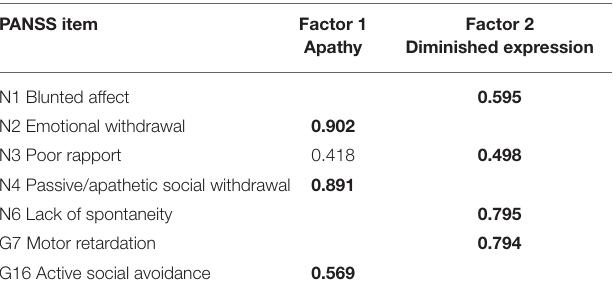
TABLE 3 | Factor structure.